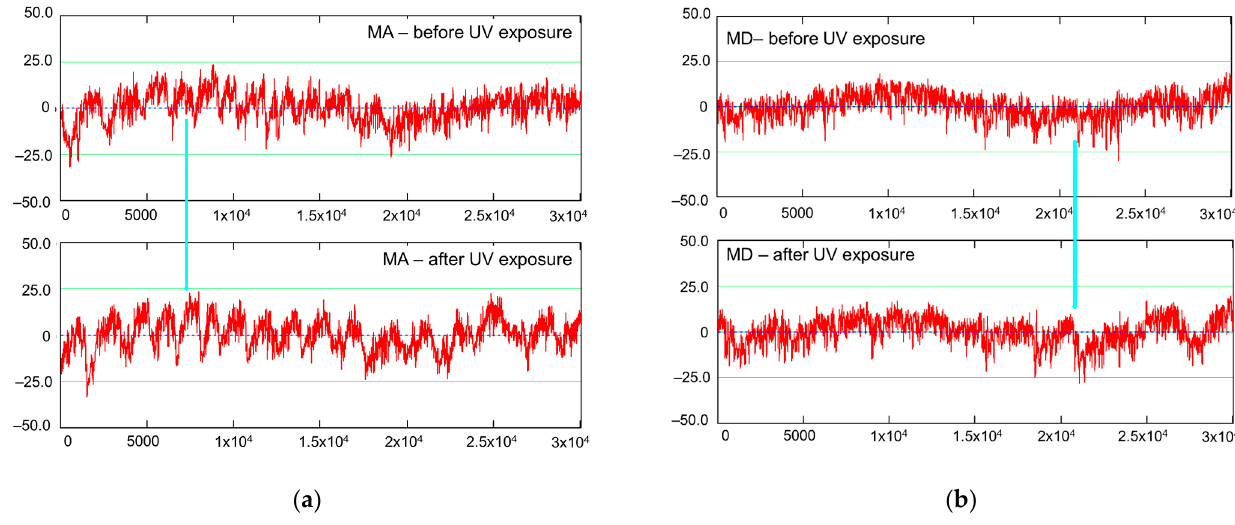
Figure 9. Comparisons of the primary profiles in the case of the MA and MD spruce boards, before (above) and after UV exposure (below): ( a ) sample grade MA; ( b ) sample grade MD (legend: the blue arrow highlights the differences in the roughness profiles).